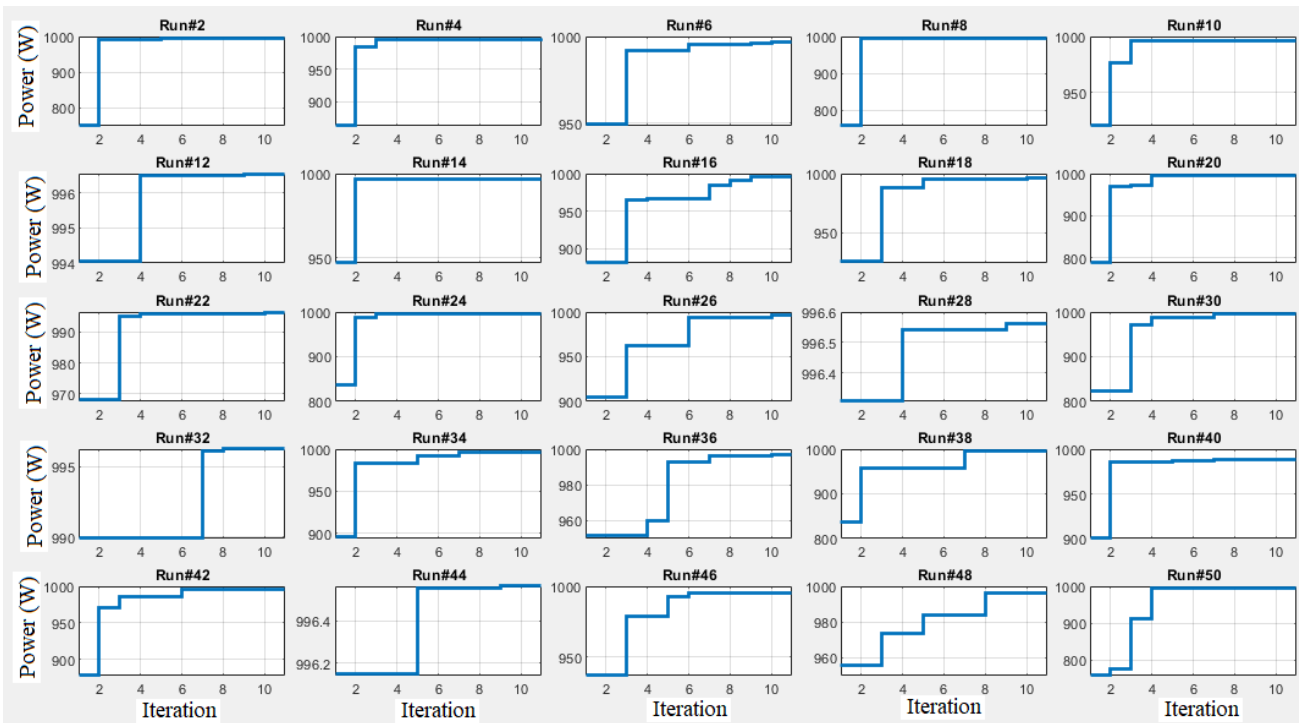
Figure A1. The PV power variation during optimization process using SFS based tracker under fifth shading scenario.